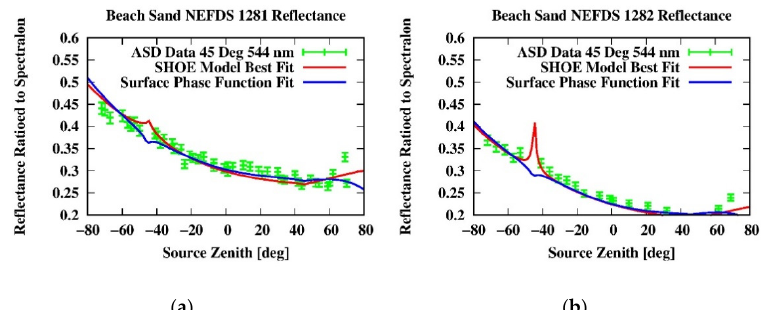
Figure 3. Laboratory white-referenced BRDF of two beach sands fit with either Hapke’s SHOE model (red) or the surface phase function variant (blue). ( a ) New Jersey Beach Sand NEFDS designation 1281SOLH, USGS laboratory Field Spec Pro data taken at 45 degrees Source Zenith. ( b ) New Jersey Beach Sand NEFDS 1282SOLH data taken at 45 degrees Source Zenith. Note the dip in the reflectance at backscatter for the surface phase function model is a result of taking a ratio with Spectralon, which has a slight increase in reflectance at zero phase angle.